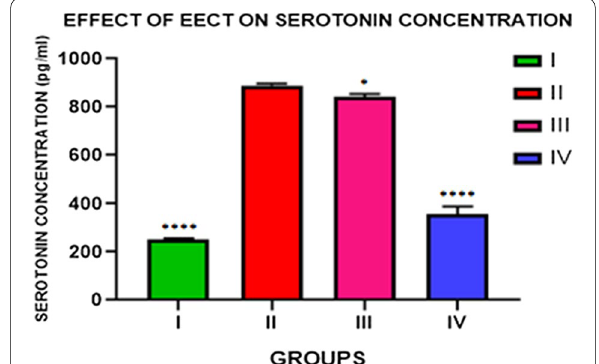
Fig. 5 Effect of EECT on serotonin